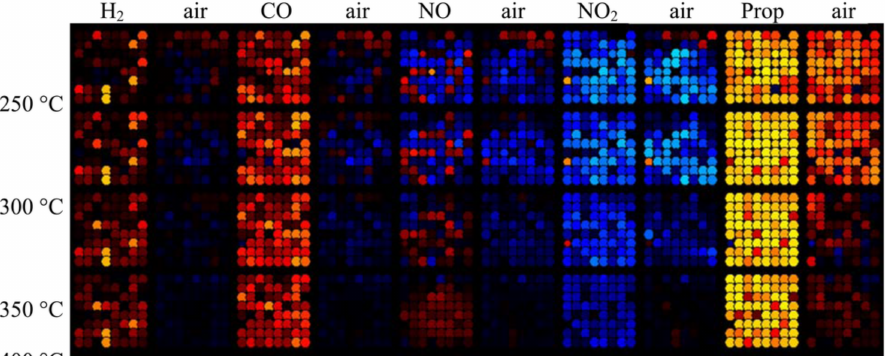
Figure 26. The relative sensitivities of the sample plate for Trellis-plot. The temperature increased from low to high on the left with sequences of five different types of gases. The concentration of the gases is H 2 25 ppm, CO 50 ppm, NO 5 ppm and propene 25 ppm. Reprint with the permission from reference [86]. MDPI Open